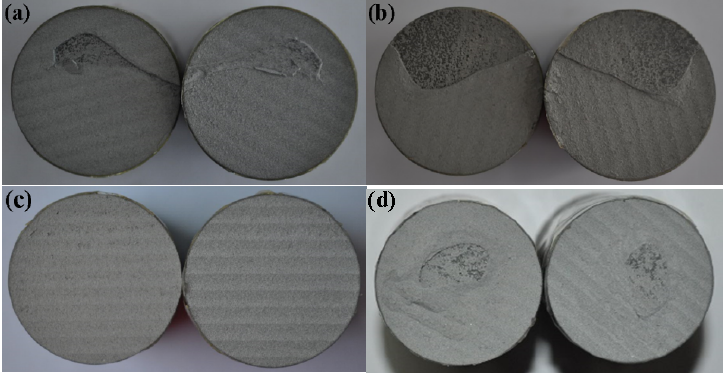
Figure 8. Photograph of the fracture section of the composite coatings with different amounts of Ni powder: ( a ) 10 wt %, ( b ) 15 wt %, ( c ) 20 wt % and ( d ) 25 wt %. powder: ( a ) 10 wt %, ( b ) 15 wt %, ( c ) 20 wt % and ( d ) 25 wt %.